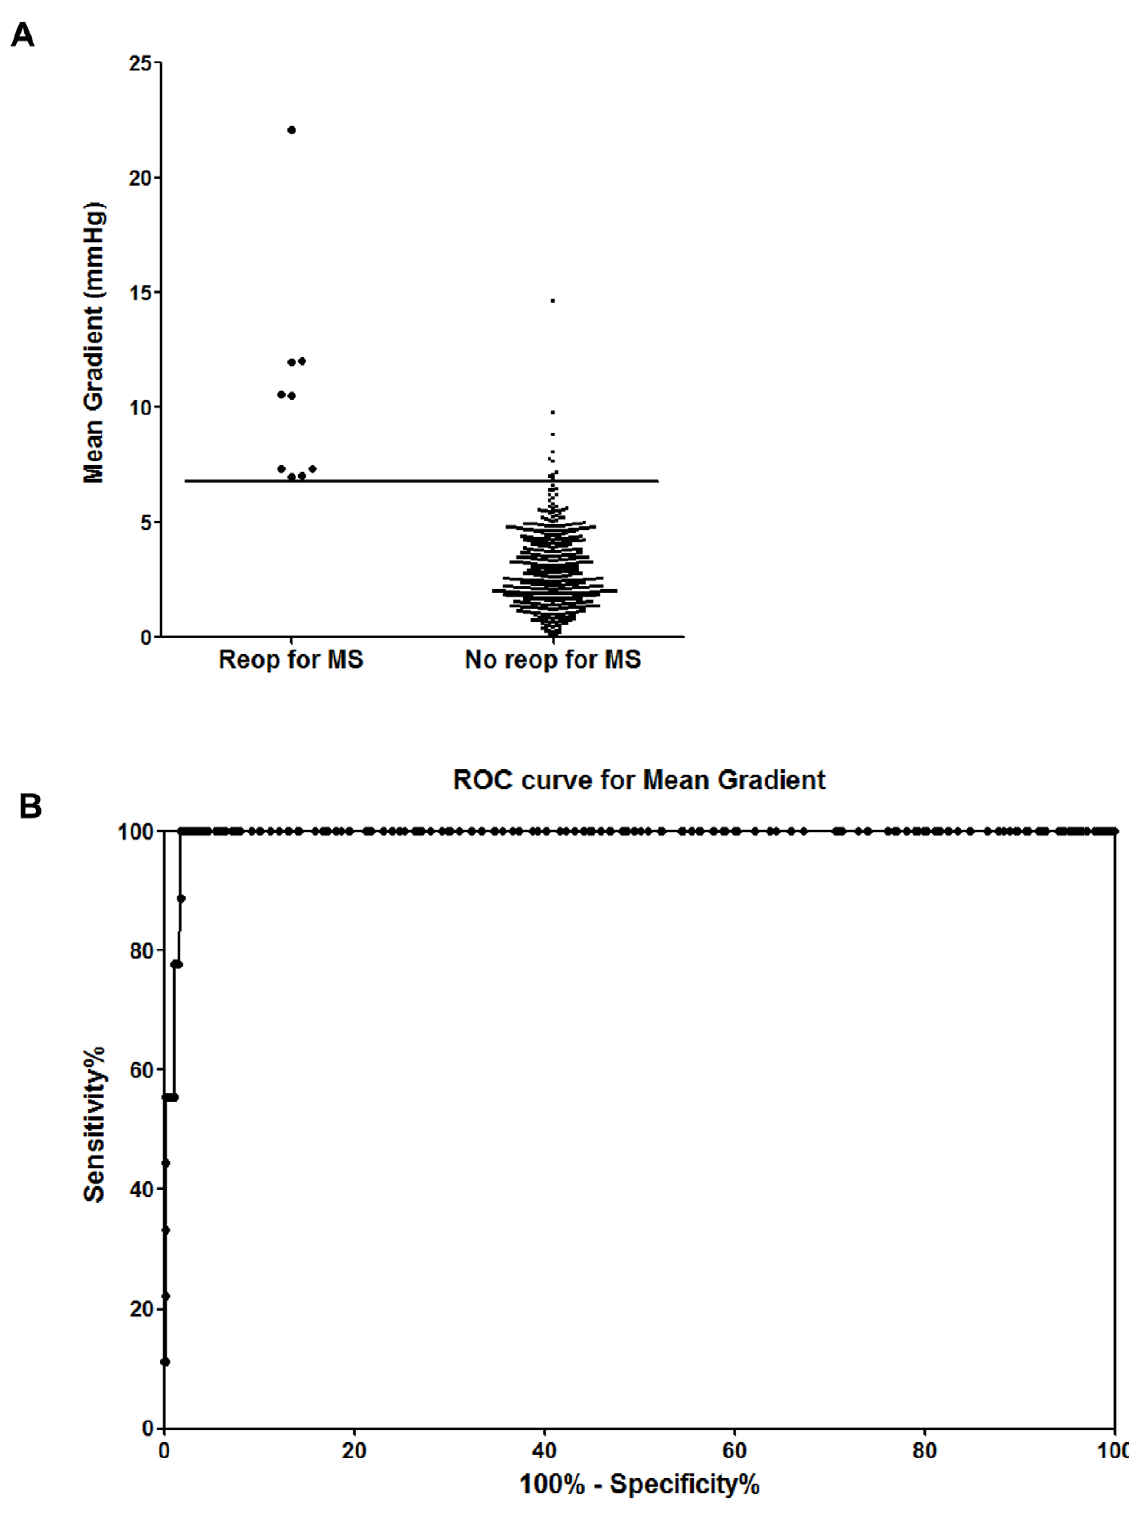
Figure 2. Distribution of mean gradients, split by the requirement for reoperation for mitral stenosis (MS). (A) A mean gradient of $ 7 mm Hg, best separated cases requiring reoperation for MS from those that did not. (B) Receiver operator curves (ROC) for mean transmitral pressure gradients. The area under the curve (AUC [SE]) for mean transmitral pressure gradients (0.993 [0.003]) showed strong discriminating ability.